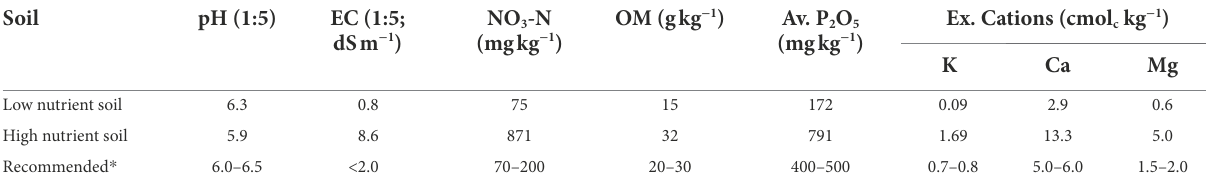
TABLE 1 Chemical properties of soils before transplanting tomato plants.